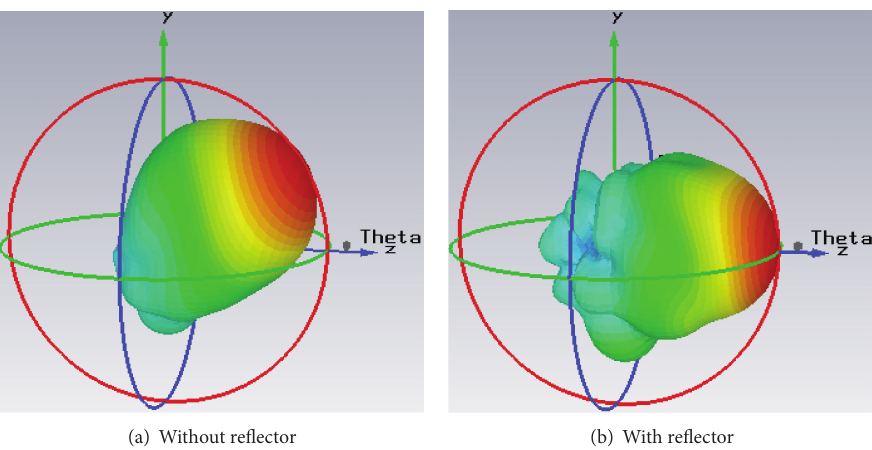
Figure 12: Bevel-cut 3D gain patterns using CST: (a) without reflector and (b) with reflector.